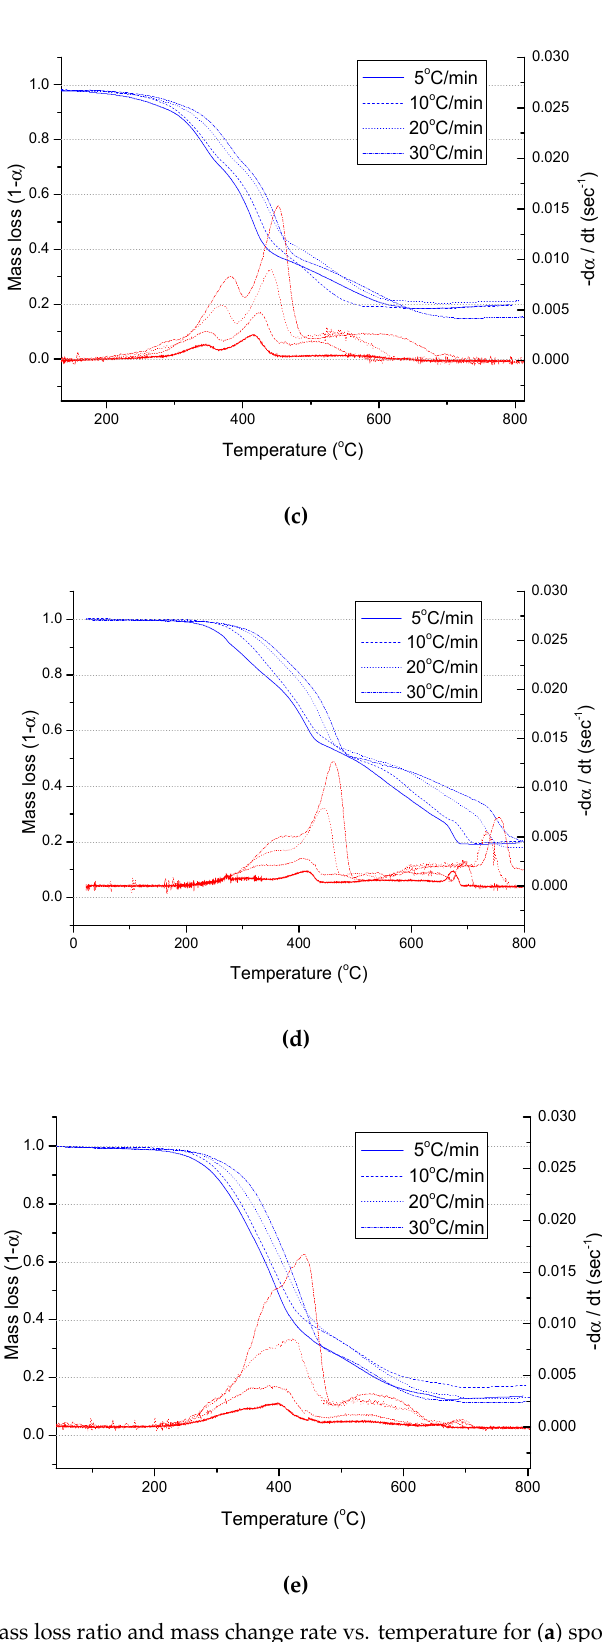
Figure 1. Sample mass loss ratio and mass change rate vs. temperature for ( a ) sponge foam, ( b ) plastic, ( c ) fiber, ( d ) rubber, and ( e ) mixed ASR.